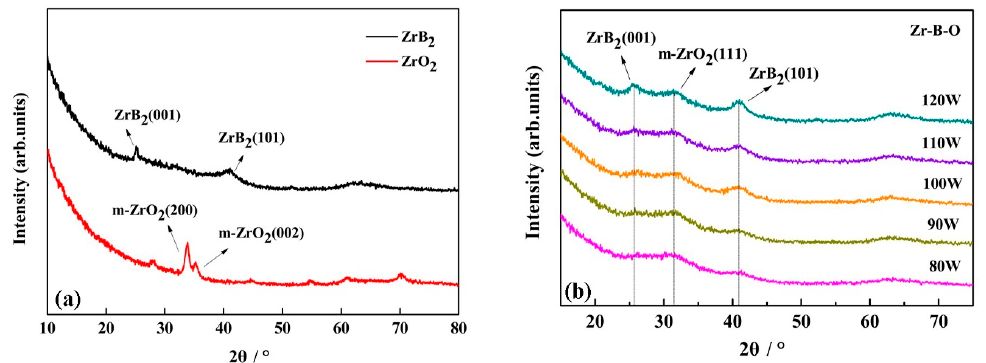
Figure 3. ( a ) XRD patterns of ZrB 2 , ZrO 2 monolayers and ( b ) Zr-B-O nanocomposite films at different sputtering power of ZrB 2 target.